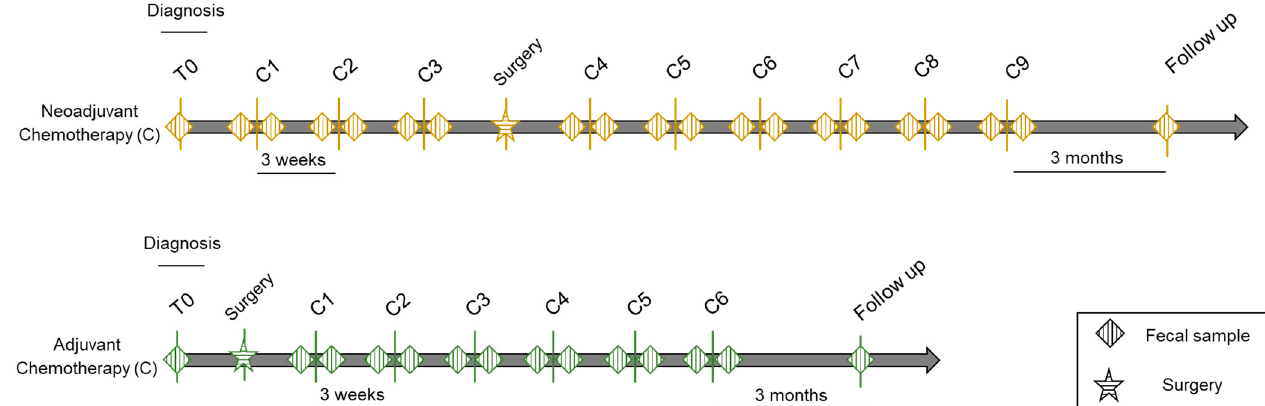
Figure 1. Study design. Schematic representation of fecal sampling for patients with epithelial ovarian cancer given neoadjuvant (top) or adjuvant (bottom) chemotherapy. Diamonds indicate sampling time-points, i.e., at diagnosis (T0), before and after each chemotherapy cycle (C), and at follow-ups every 3 months from the end of therapy. Chemotherapy courses were repeated every 3 weeks depending on the tumor response.